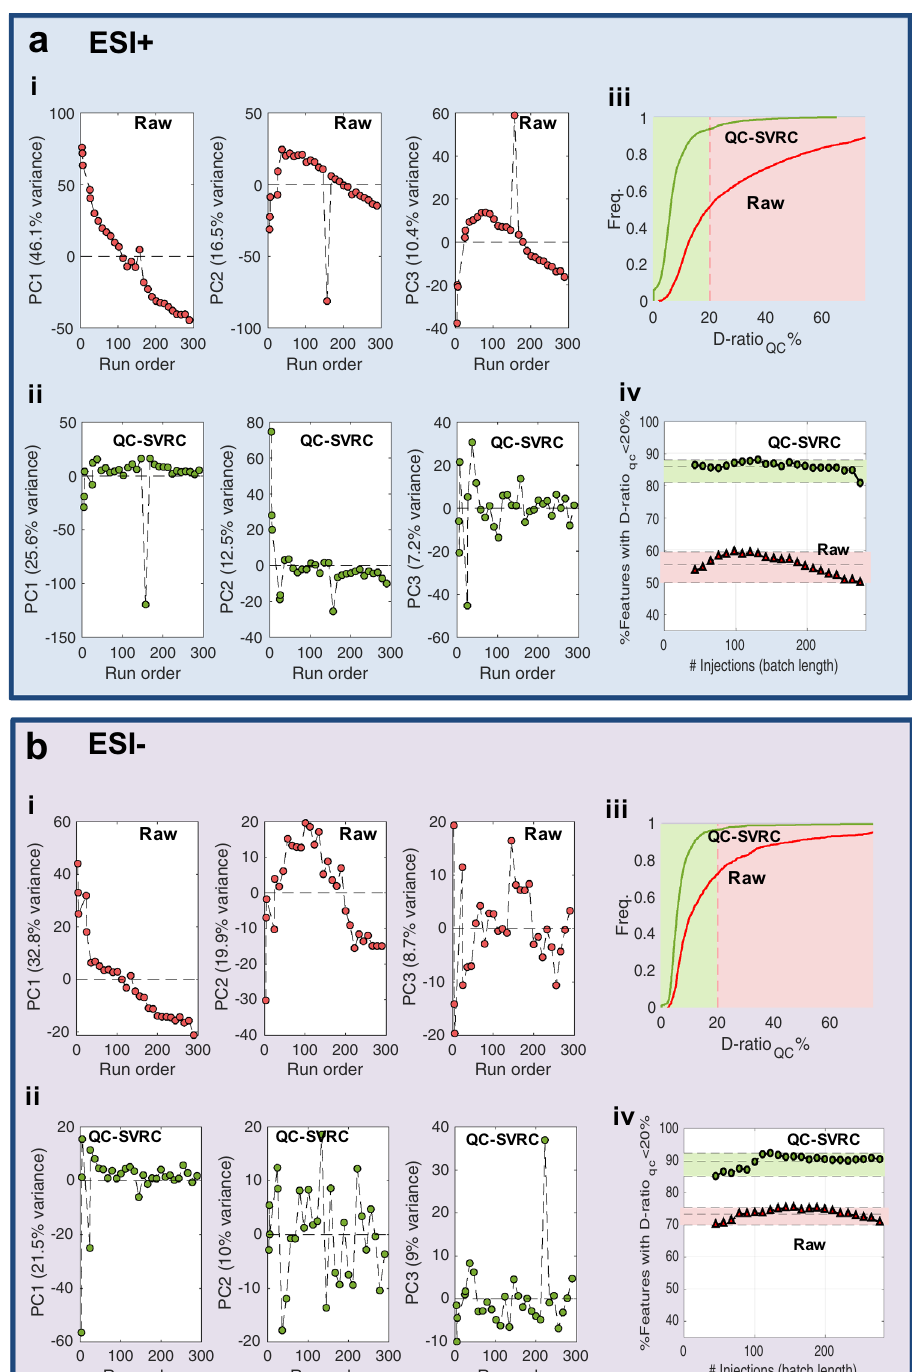
Figure 2. QC-SVRC correction eliminates within batch effect and improves data quality increasing the percentage of metabolites retained after data pre-processing. Results from ESI+ ( a ) and ESI− ( b ). PCA of the QC samples before (i) and after (ii) QC-SVR correction. Plots show the run order versus PC1, PC2 or PC3 and each dot represents a QC sample. The percentage of variance in each component is shown (% variance) (i, ii). Cumulative distribution functions of the D-ratio QC % in the original dataset and after QC-SVRC (iii). Percentage of variables showing a D-ratio QC < 20% in batches with different number of injections